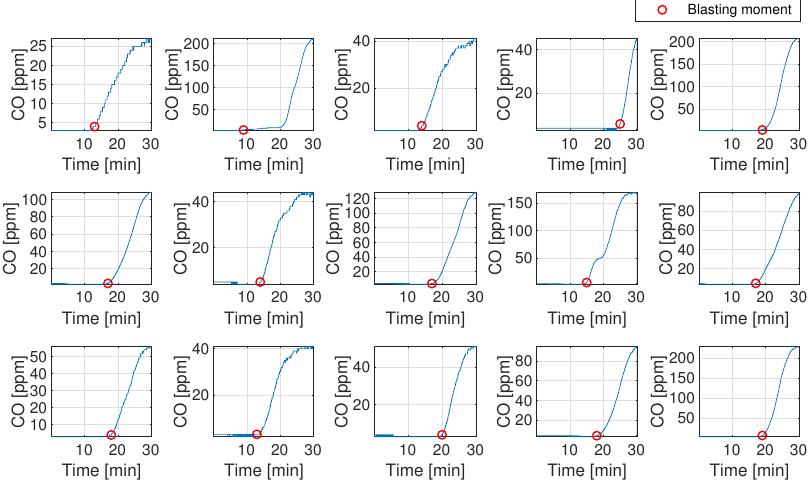
Figure A1. The blasting moment detection—Part